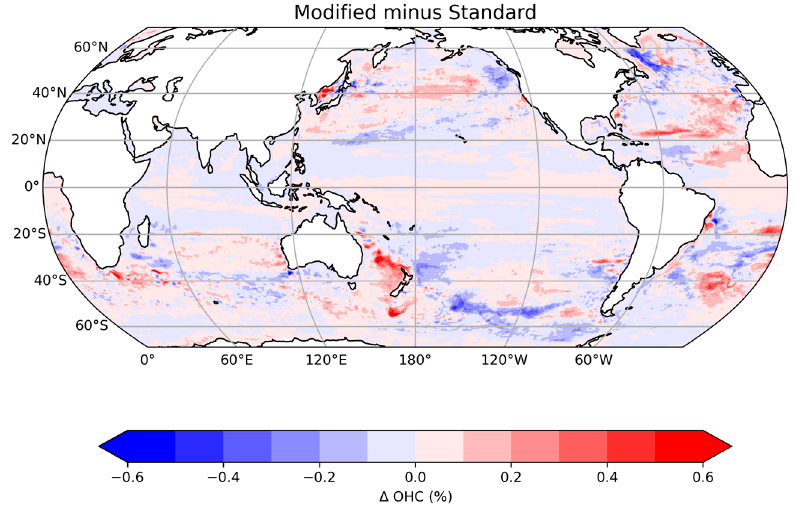
Figure 3. Difference between the climatological mean projected changes in Ocean Heat Content (OHC) for simulations without wave-induced mixing (Standard) and with wave induced mixing (Modified). Red indicates a wave-induced increase in projected ocean heat uptake; blue indicates a decrease. This difference is normalized by present day OHC (M1A). OHC is accumulated over the upper 200 m.